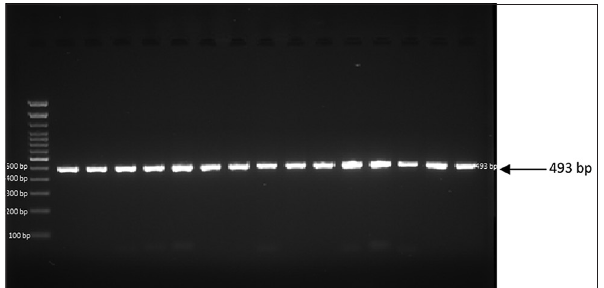
Figure-2: Melanocortin-4 receptor gene amplification of Madrasin cattle.